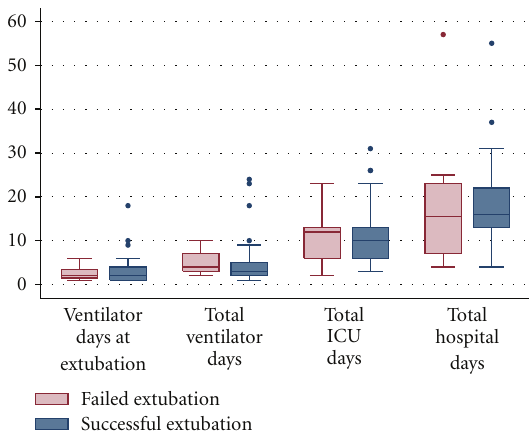
Figure 2: Glasgow Coma Scale (GCS) scores in middle cerebral artery acute ischemic stroke patients in whom extubation was successful versus failed.